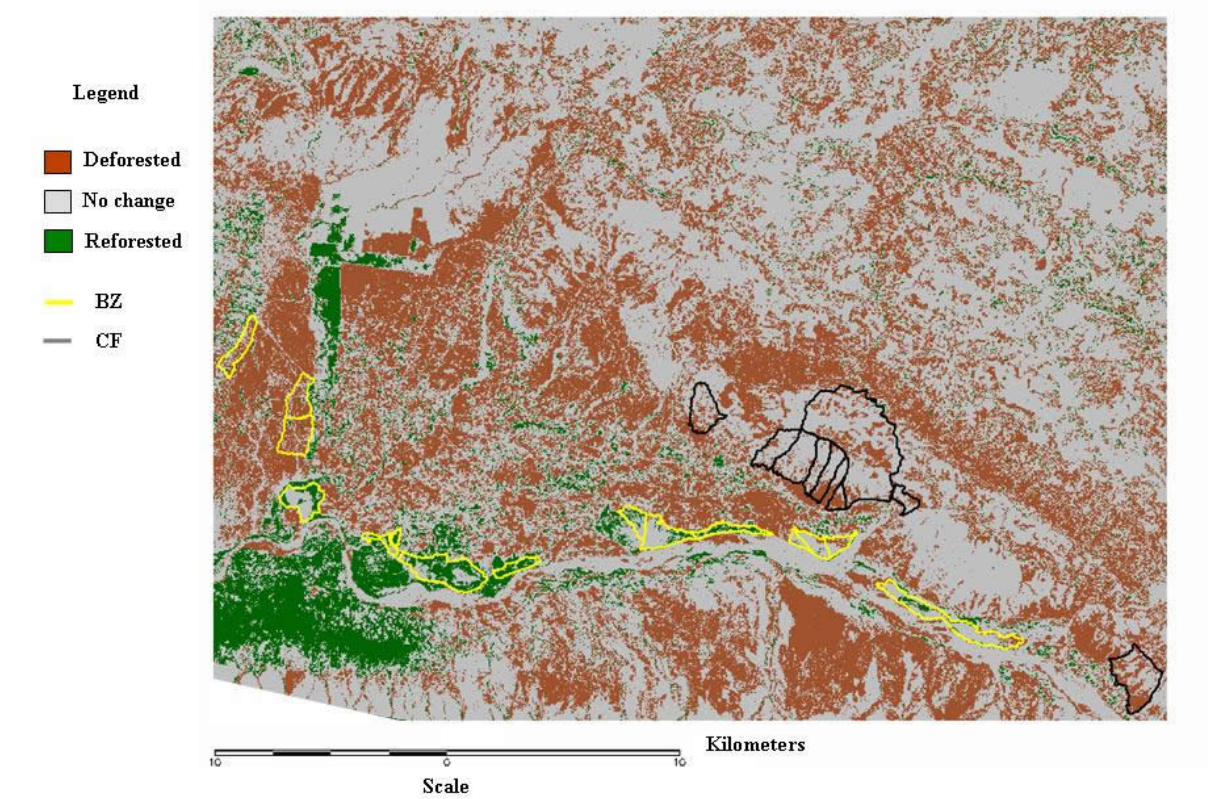
Fig. 2 . 1989–2000 change classification for East Chitwan, overlaid with community-forest and buffer-zone